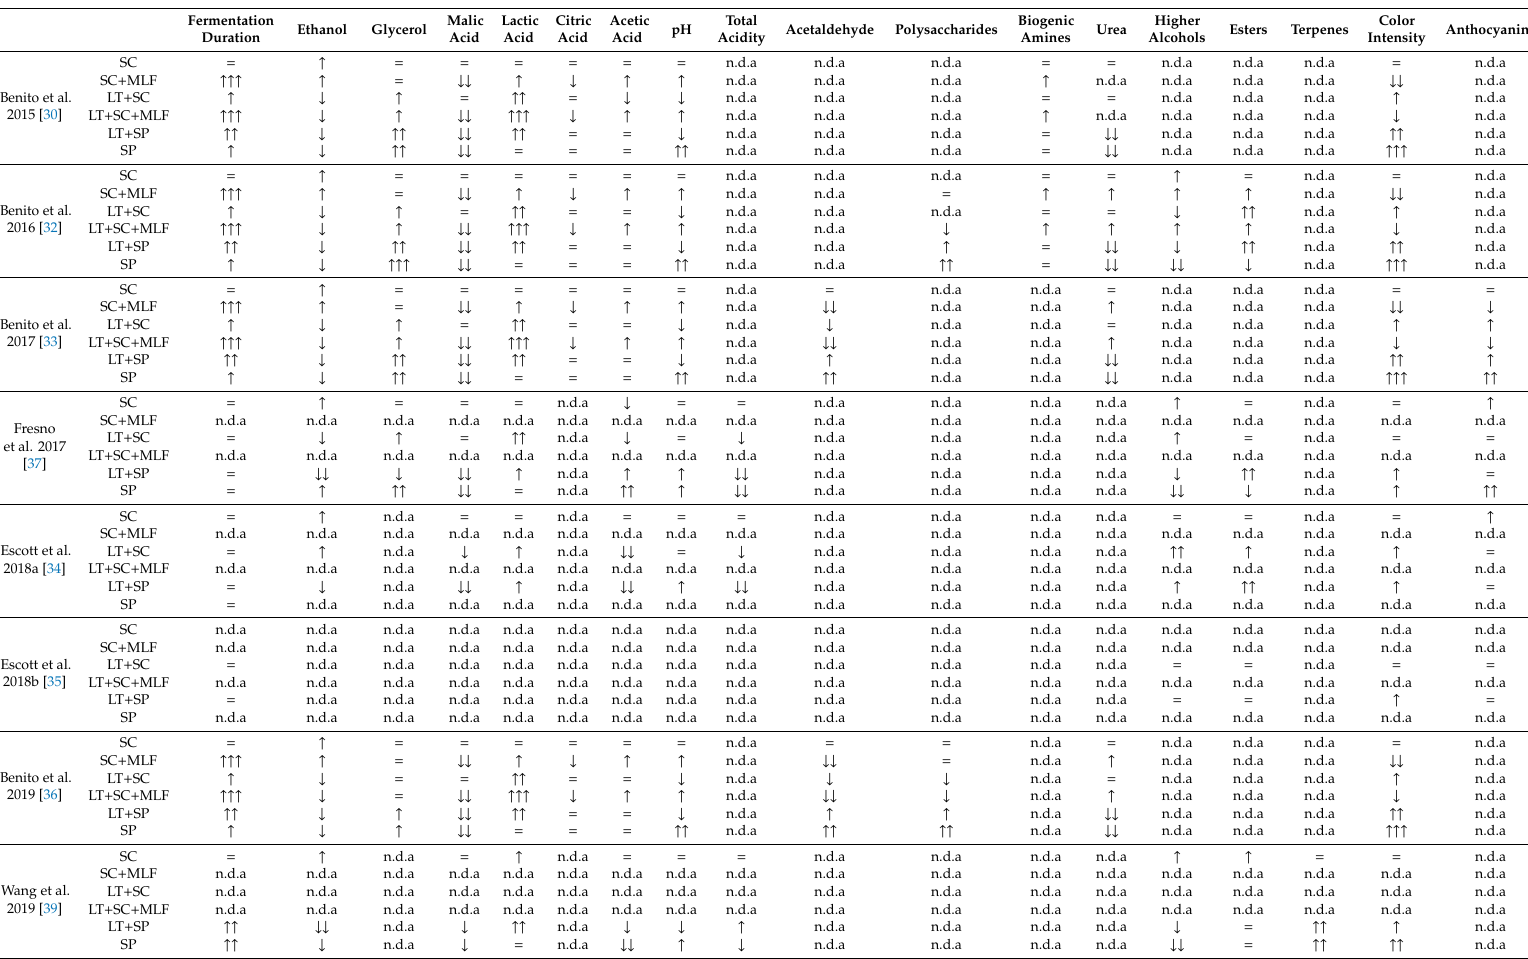
Table 2. Comparison of parameters in di ff erent studies involving fermentation combining the use of Lachancea thermotolerans and Schizosaccharomyces pombe